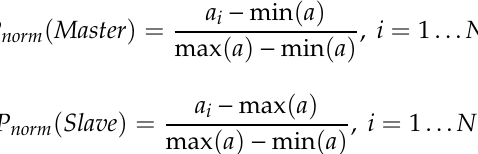
Figure 16. Error between master and slave trajectories for the 2 nd link.